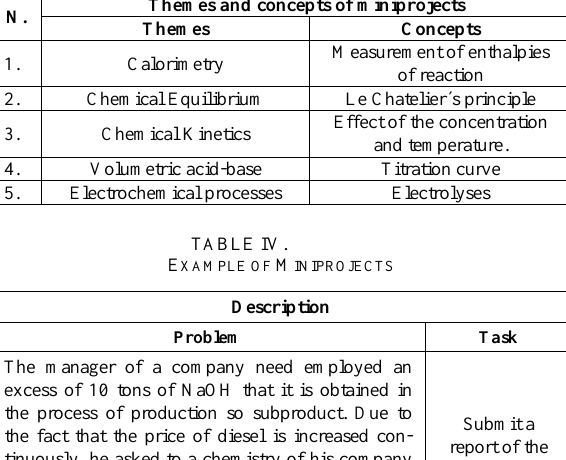
TABLE III. L IST OF M INIPROJECTS Themes and concepts of miniprojects N.